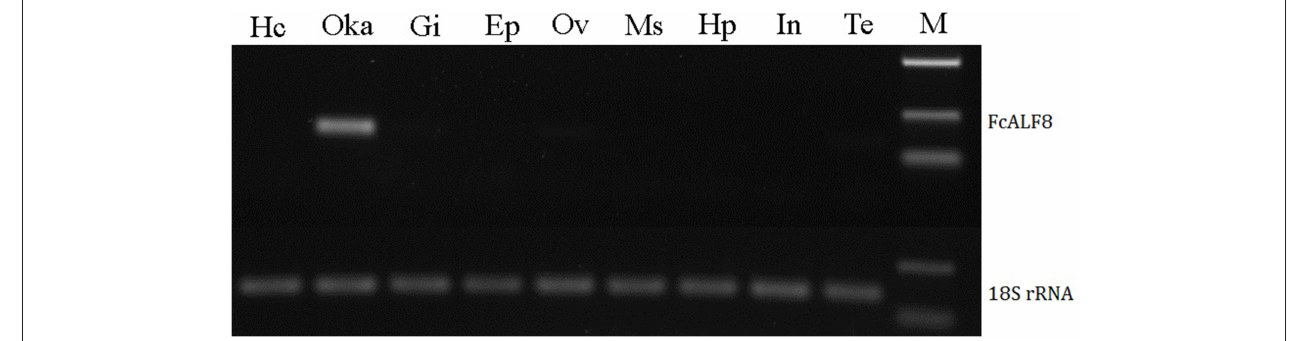
FIGURE 3 | Tissue distribution of FcALF8. Hc, hemocyte; Oka, lymphoid organ; Gi, gill; Ep, epidermis; Ov, ovary; Ms, muscle; Hp, hepatopancreas; In, intestine; Te, testis; M, DL2000 marker. 18S rRNA was used as internal reference gene.